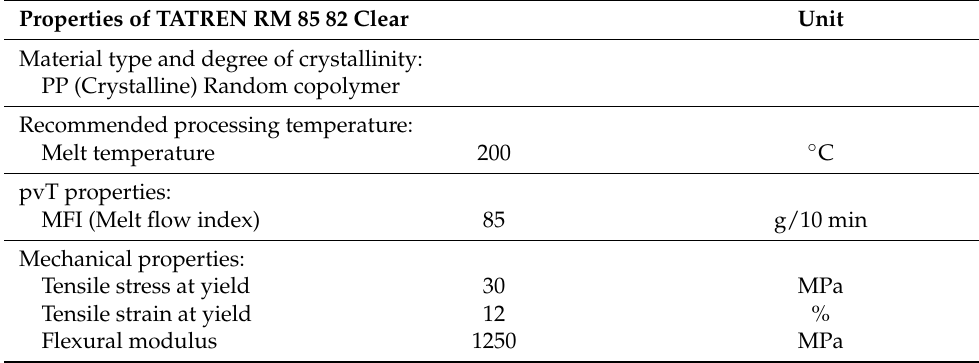
Table 2. The properties of the examined polymer. Properties of TATREN RM 85 82 Clear